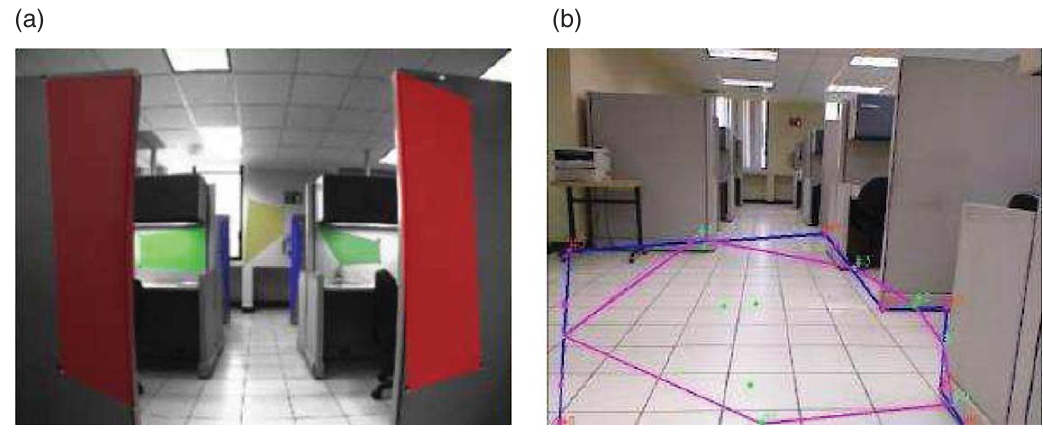
Fig. 8. (a) (left) Planes detection using the RGB-d sensor; (b) (right) polygon of free space avoiding obstacles delimited by the planes.